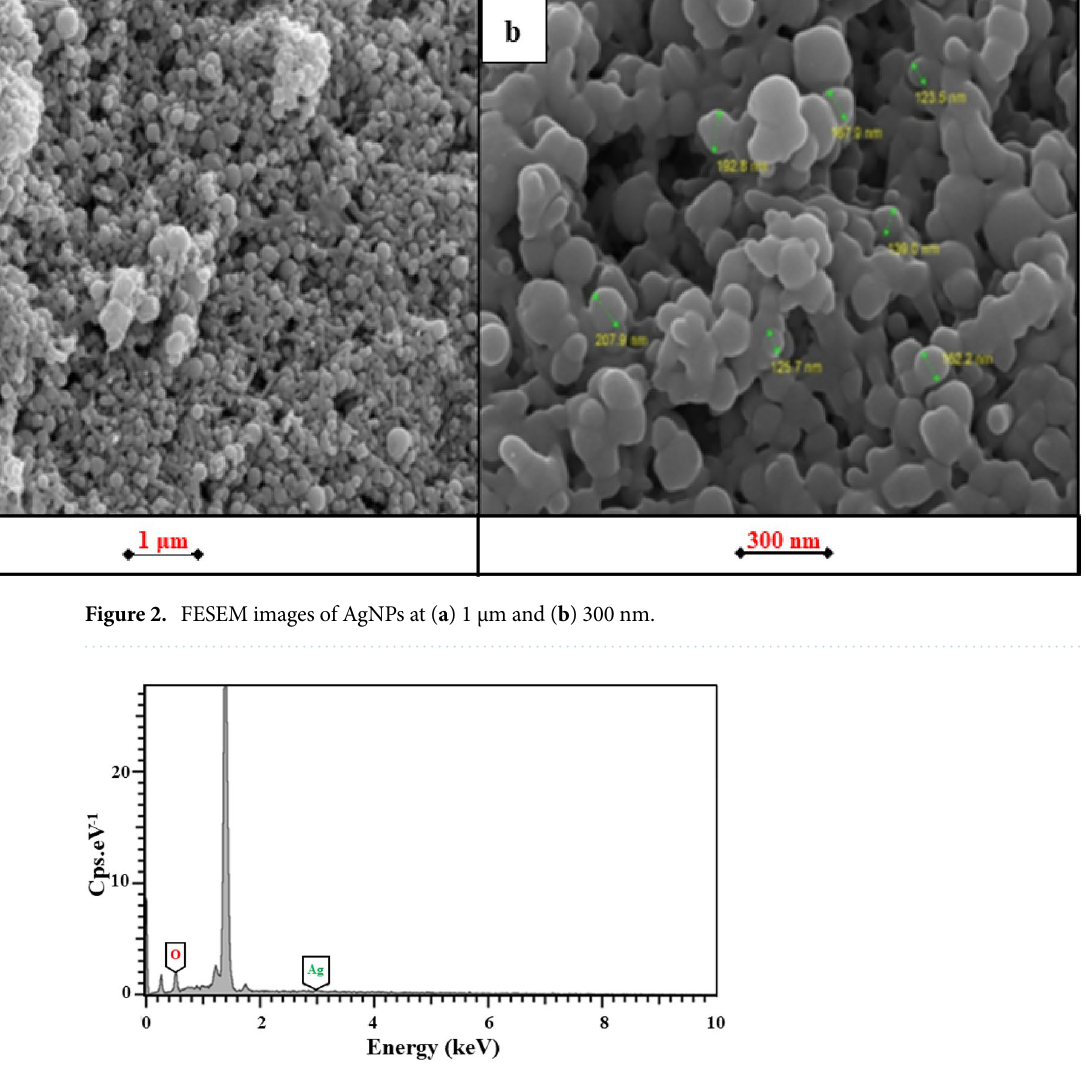
Figure 3. EDS of Ag/AgO